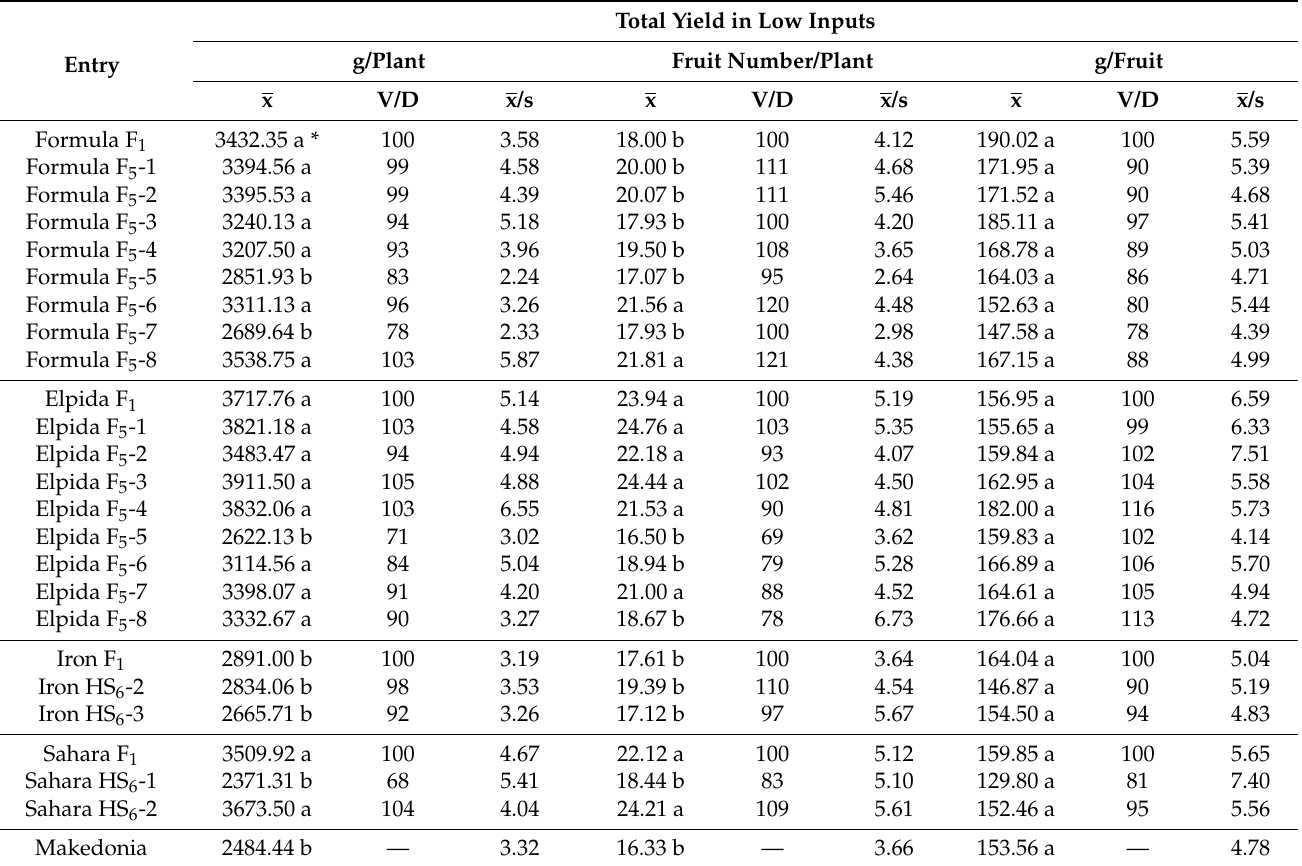
Table 4. Total fruit yield (g/plant, fruit number/plant, and g/fruit), vigor/depression (% of its corresponding hybrid), and stability of performance ( x /s) of the hybrids and new recombinant inbred lines, in the low-input farming